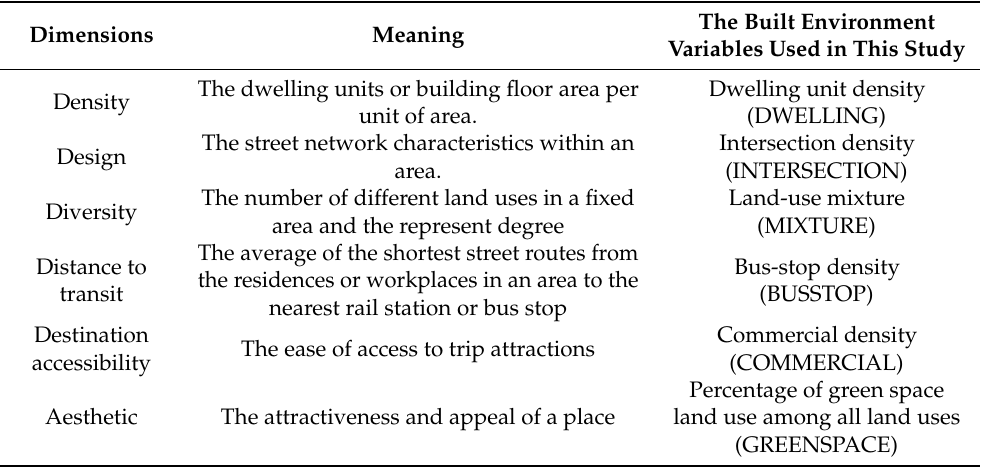
Figure 2. The calculation of commercial accessibility. Table 3. Definition and descriptive statistics of variables. Table 2. The description of built environment